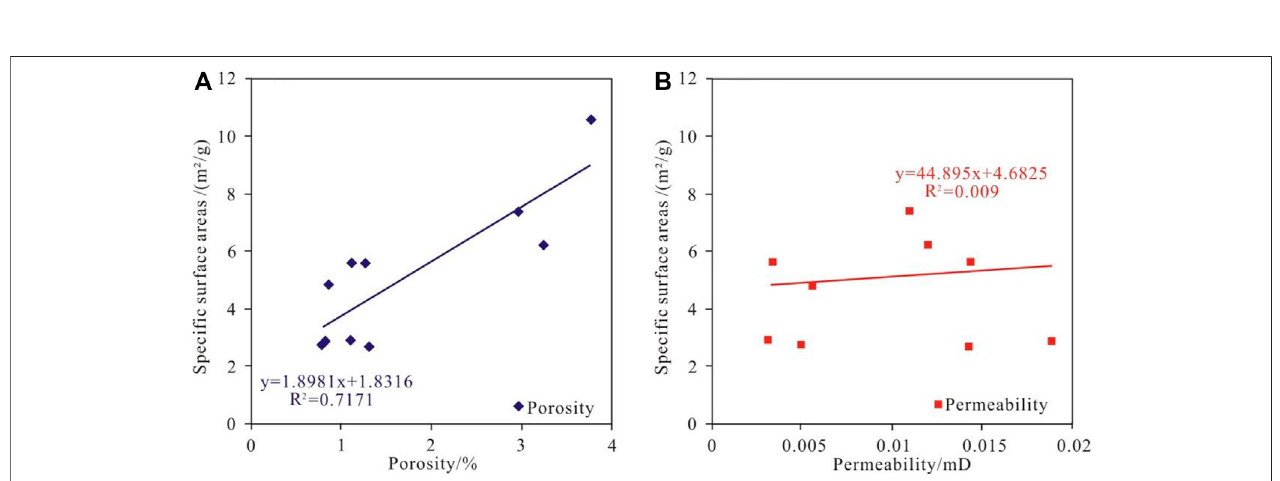
FIGURE 17 | Correlation of SSA with porosity and permeability of Shanxi Formation shale. Correlation of SSA with (A) porosity, (B) permeability.